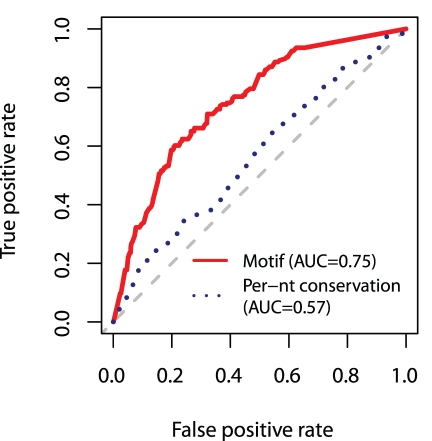
Power of existing measures to predict the effect of regulatory polymorphism.ROC curve evaluating the power of two measures on the 1,368 SNPs in this study found within the region of protein-DNA contact, 186 of which significantly affect occupancy. Dotted blue line represents predictions by ranking SNPs in decreasing order of inferred purifying selection (phyloP per-nucleotide conservation score) at the location of the SNP. Solid red line represents predictions by ranking SNPs based on the difference in log-odds scores between alleles. Area under the curve (AUC) summarizes overall predictive power. Gray line indicates a random predictor and has an AUC of 50%. A perfect predictor would be plotted as a right angle, ranking all functional SNPs ahead of all nonfunctional SNPs, and would have an AUC of 1.0. While per-nt conservation performs little better than chance, consideration of binding energetics substantially improves performance.